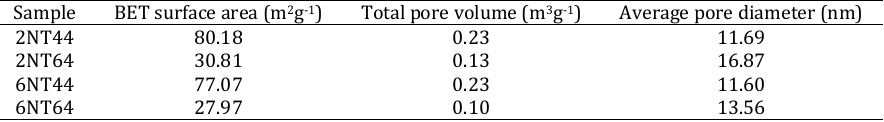
Fig. 4: Adsorption-desorption isotherm for different N-doped TiO 2 sample